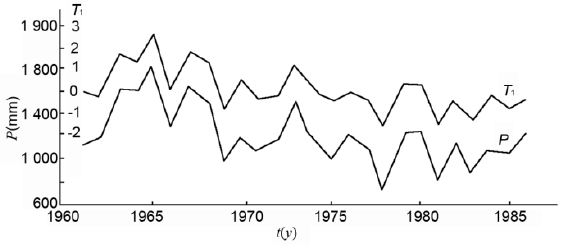
( ) T t in the Taedong River Basin. 1